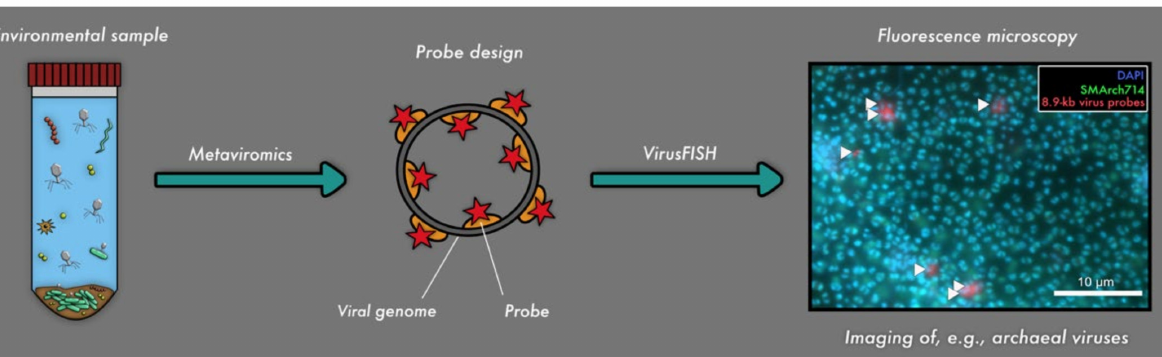
Figure 2. Linkage of metaviromics and fluorescence microscopy for detecting uncultivated viruses. The genome of the virus is detected in silico and used for respective probe design (Barrero-Canosa and Moraru, 2019 [35]), followed by detection of the respective viral genomes in situ (i.e., virusFISH